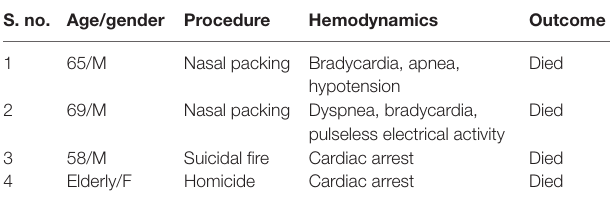
TAble 1 | Unusual cases of trigemino-cardiac